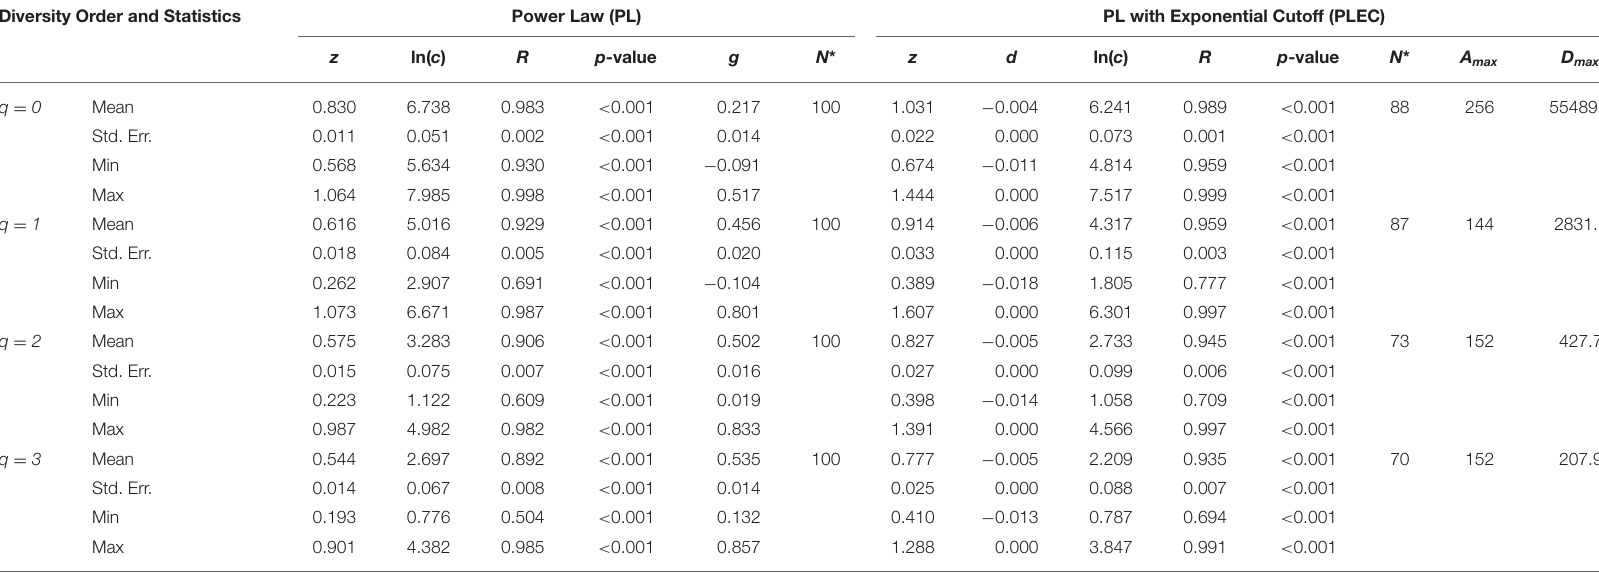
TABLE 2 | The parameters of DAR (diversity-area relationship) for the Bacteria in the hot springs, computed with 100 times of re-sampling from the totally permutated hot springs. Diversity Order and Statistics Power Law